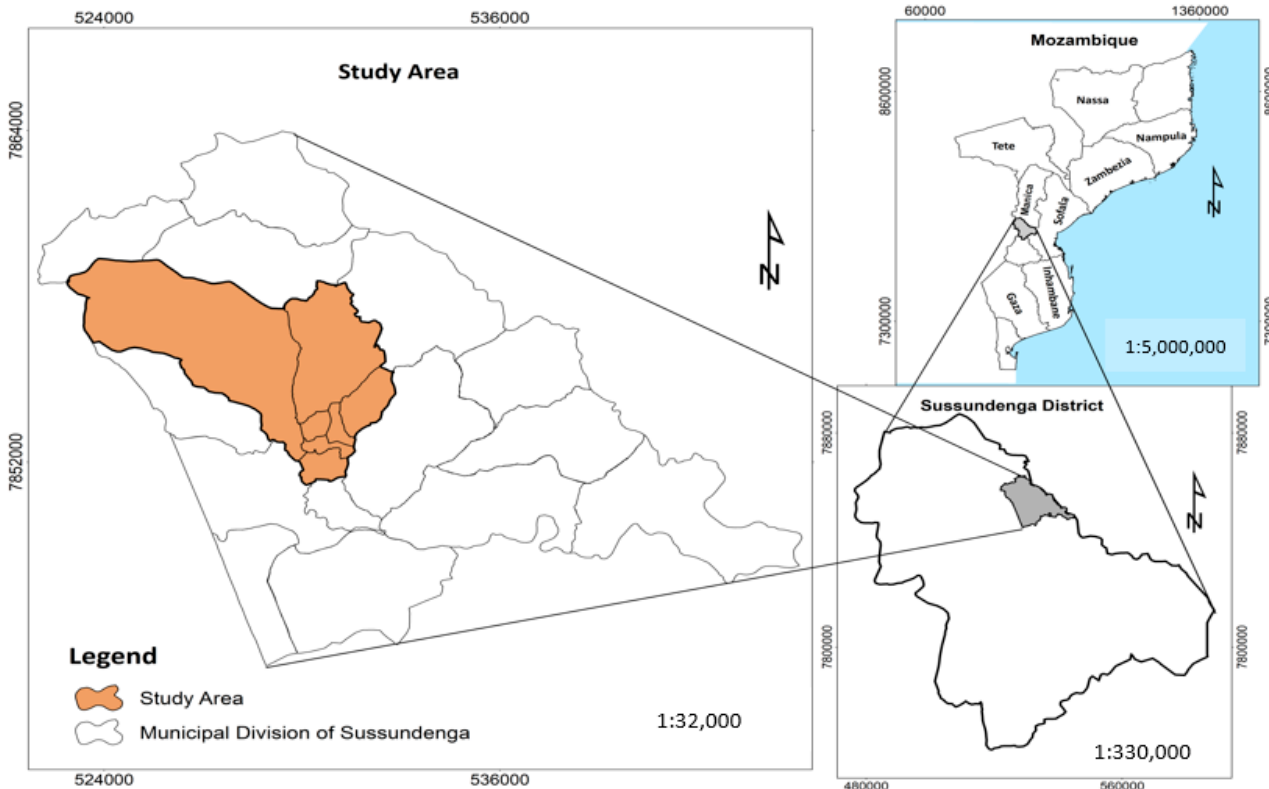
Figure 1. Map of Mozambique, Sussundenga Village and the study area.